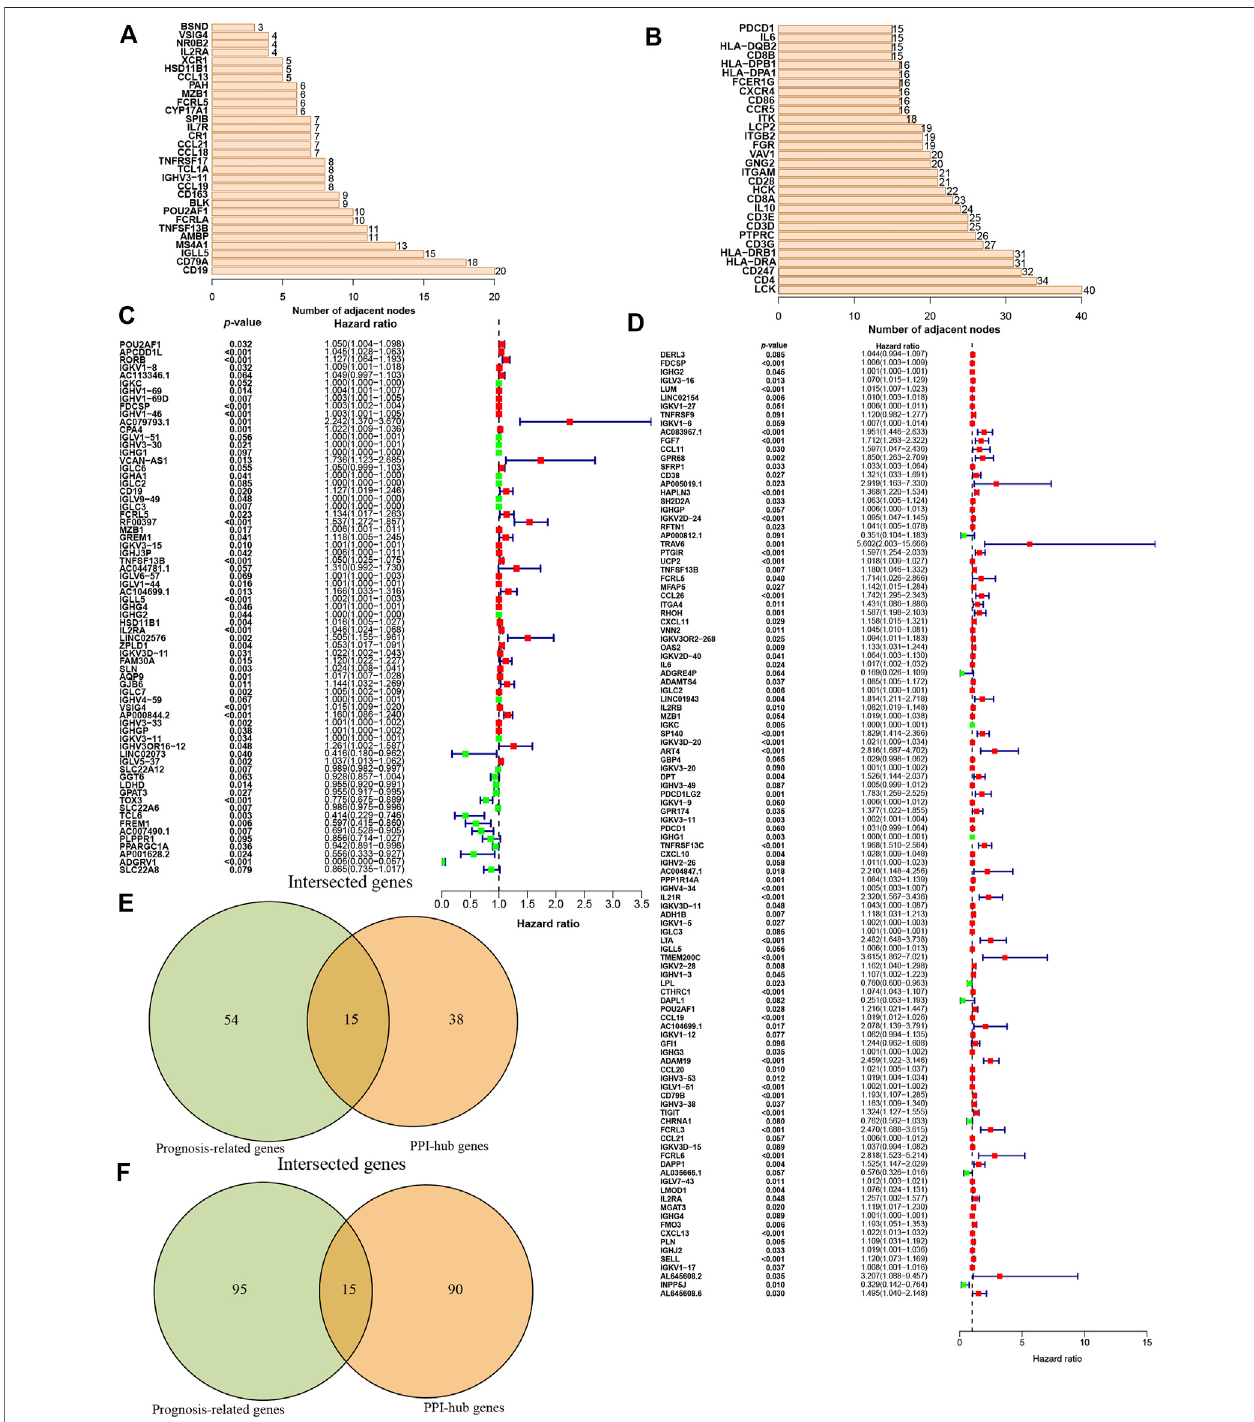
FIGURE 3 | Identi fi cation of the prognostic hub DEGs. (A-B) Hub DEGs ranked by the number of nodes in ccRCC (A) and Prcc (B) . (C-D) Construction of univariate Cox analysis in ccRCC (C) and pRCC (D) . (E-F) Identi fi cation of prognostic hub DEGs via Venn diagram in ccRCC (E) and pRCC (F) .